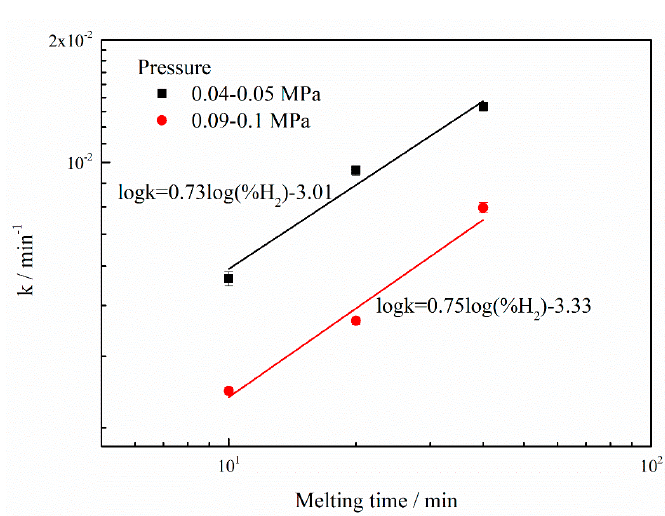
Figure 3. Dependence of the apparent manganese reduction rate constant ( k Mn ) on the hydrogen volume proportion (% H 2